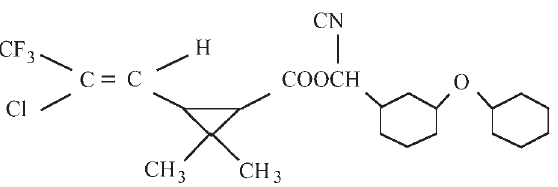
Figure 1 - Structure of the pyrethroid insecticide lambda-cyhalothrin (C 23 H 19 ClF 3 NO 3